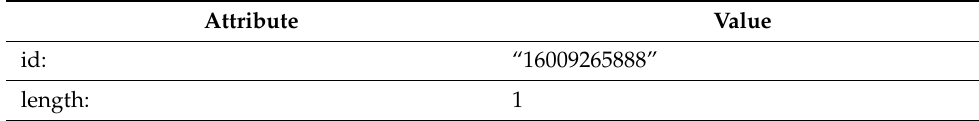
Table 12. Artifacts Found in stories.feedTray Record.